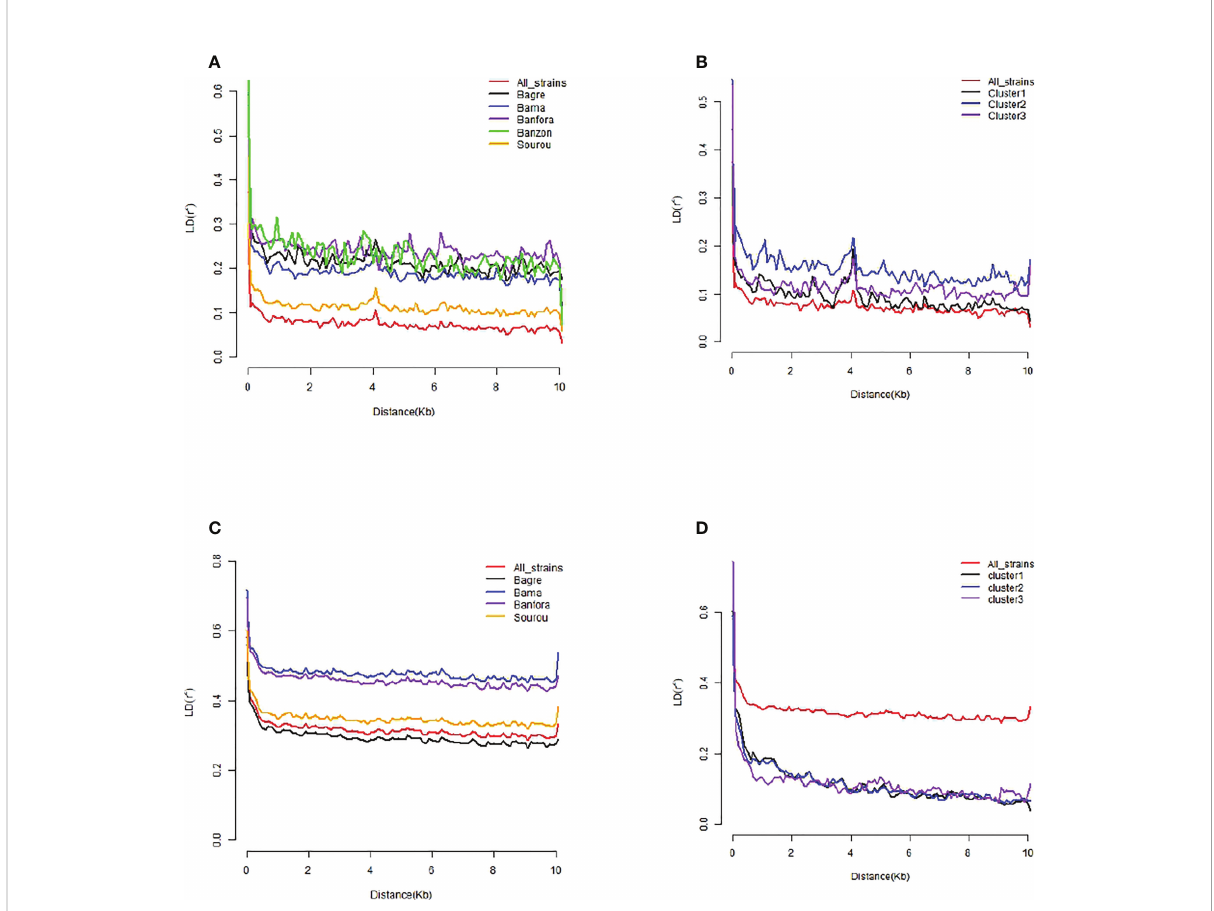
FIGURE 6 Estimated linkage disequilibrium decay (LD-decay) of Bipolaris oryzae and Exserohilum rostratum isolates. (A) LD of B. oryzae isolates per locality, (B) LD of B. oryzae isolates per cluster, (C) LD of E. rostratum isolates per locality, (D) LD of E. rostratum isolates per cluster. Localities and genetic clusters with less than 8 isolates were not presented individually (ie Banzon for E. rostratum , cluster 4 for B. oryzae and E. rostratum